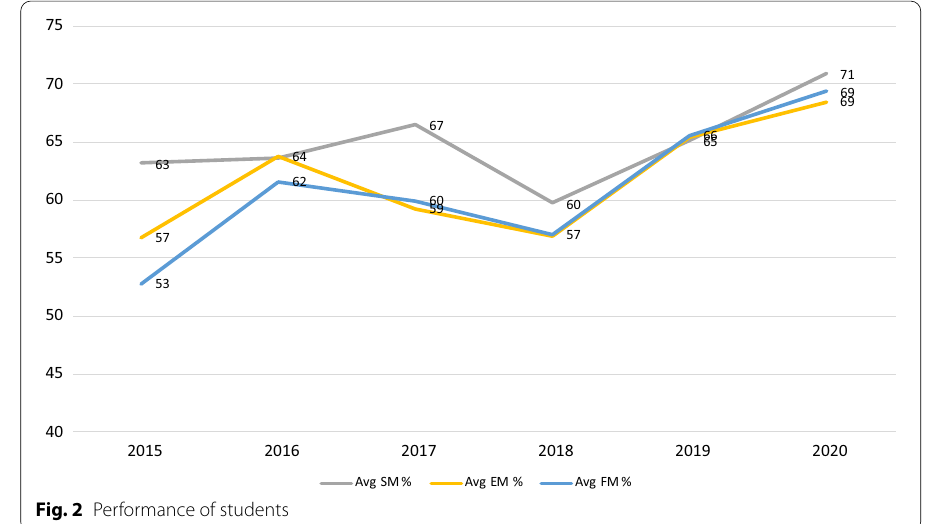
Fig. 2 Performance of students